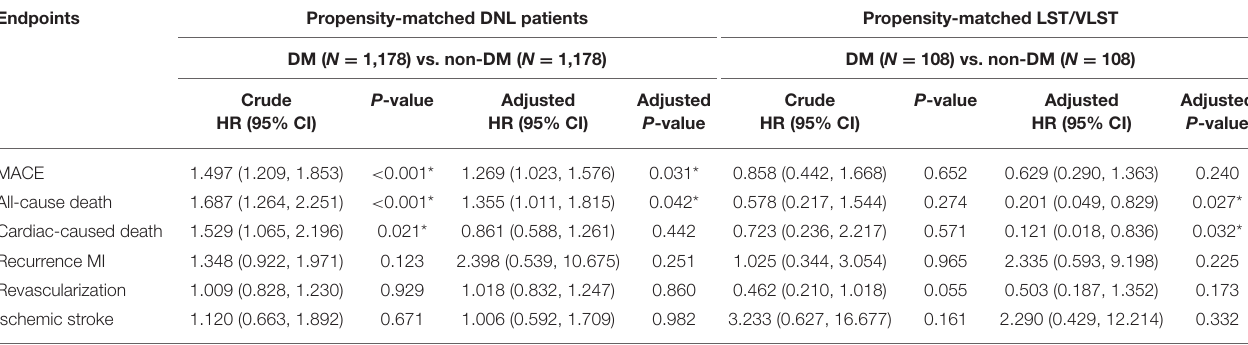
TABLE 5 | Primary outcomes by propensity score matching before and after fully adjustment.